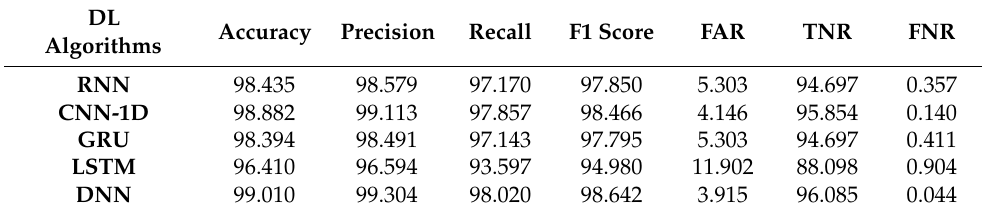
Table 4. Performance Evaluation metrics score [%].